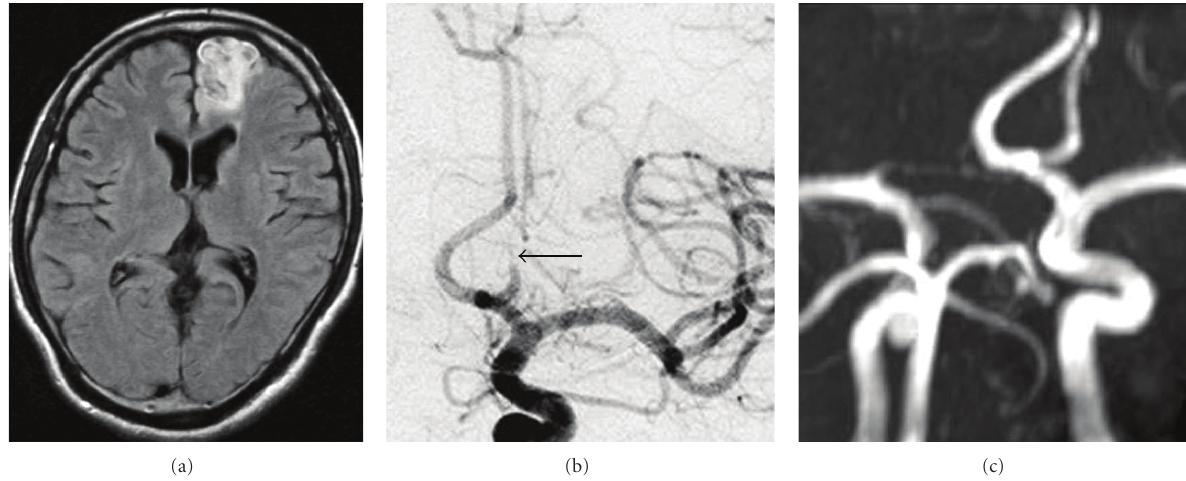
Figure 2: (a) Magnetic resonance imaging (FLAIR sequence) about one month after the onset shows infarction of the medial part of the left frontal lobe. (b) Left internal cerebral artery angiogram displays severe stenosis of the A 2 segment (arrow). (c) About 9 months after the onset, magnetic resonance angiography reveals recanalization of the left A 2